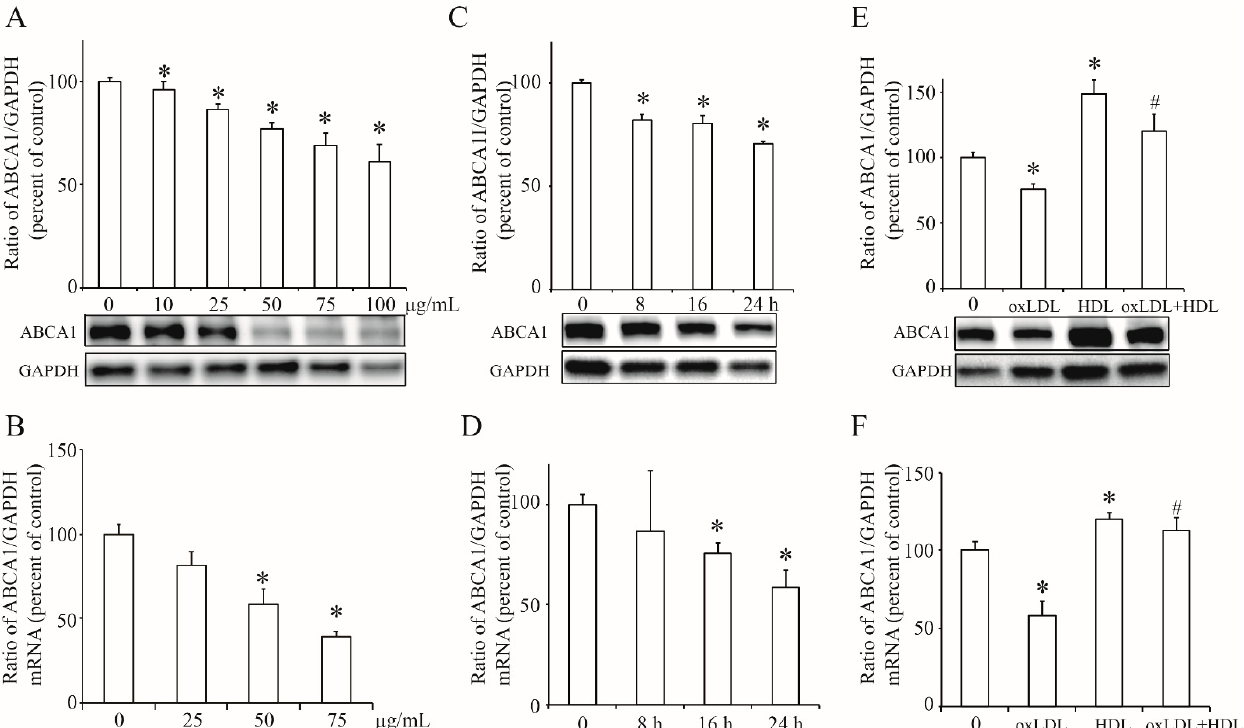
Figure 3. The effect of OxLDL on the expression of ABCA1 in INS-1 cells. ( A , B ), the protein and mRNA levels of ABCA1 in INS-1 cells treated with OxLDL at varying concentration (0, 10, 25, 50, 75, 100 μ g/mL). ( C , D ), the protein and mRNA level of ABCA1 in INS-1 cells with OxLDL at 50 μ g/mL for varying time (0, 8, 16, 24 h). ( E , F ), the protein and mRNA level of ABCA1 in INS-1 cells with OxLDL at 50 μ g/mL or HDL at 10 μ g/mL. The ratio of ABCA1 to GAPDH is shown as percent of control. The data is presented as the mean ± SEM ( n = 3) of separate experiments for each treatment group. * p < 0.05 compared to 0; # p < 0.05 compared to OxLDL.